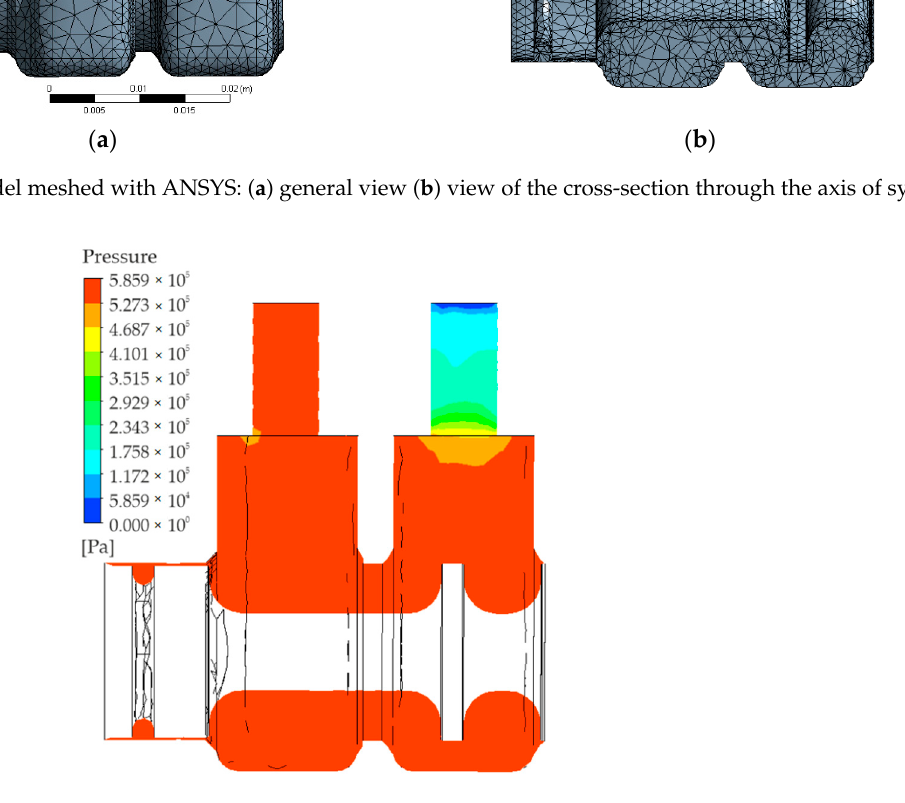
Figure 5. Valve model meshed with ANSYS: ( a ) general view ( b ) view of the cross-section through the axis of symmetry.